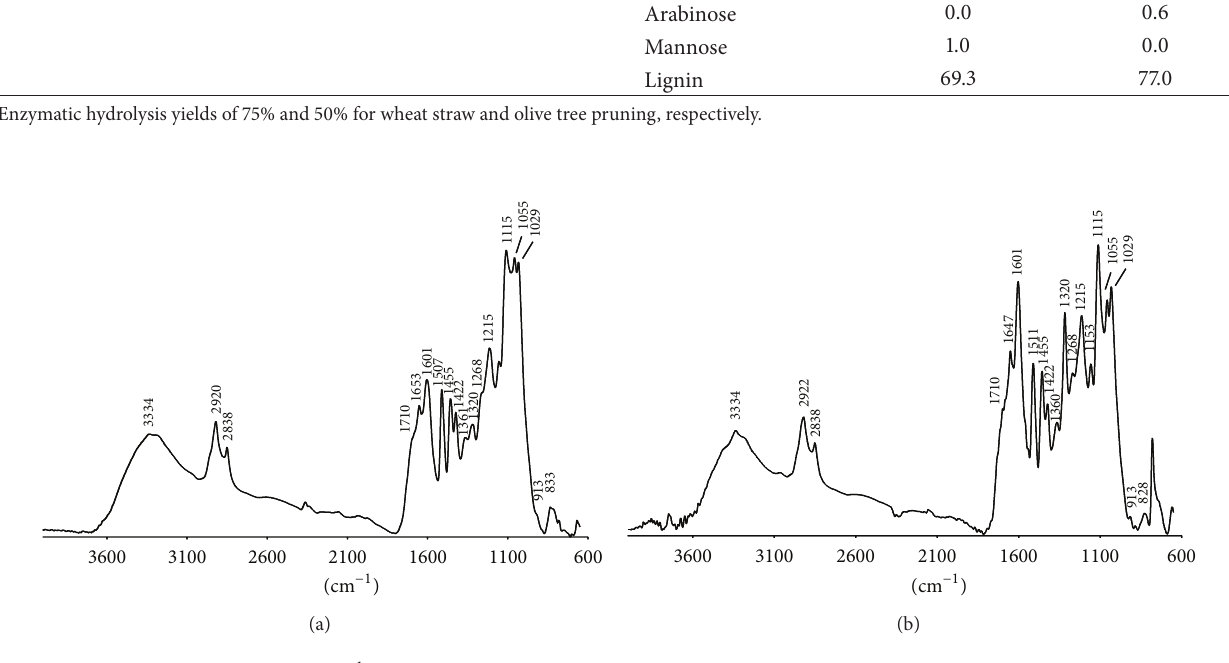
conditions based on enzymatic hydrolysis yields [3,